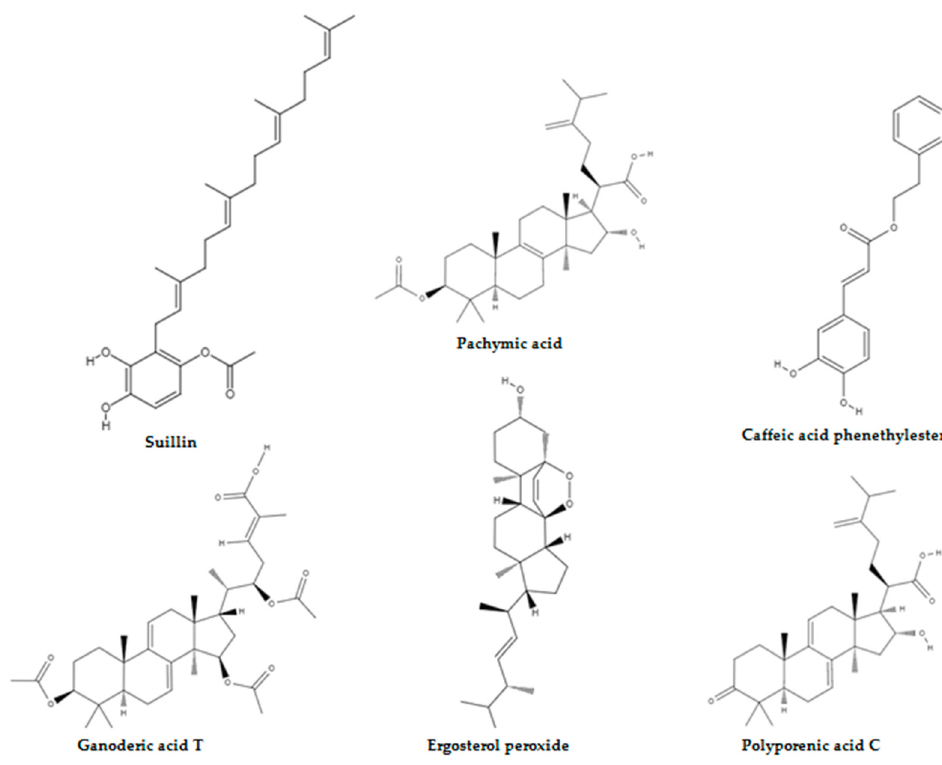
Figure 2. Mushroom-derived compounds that have anticancer potential.